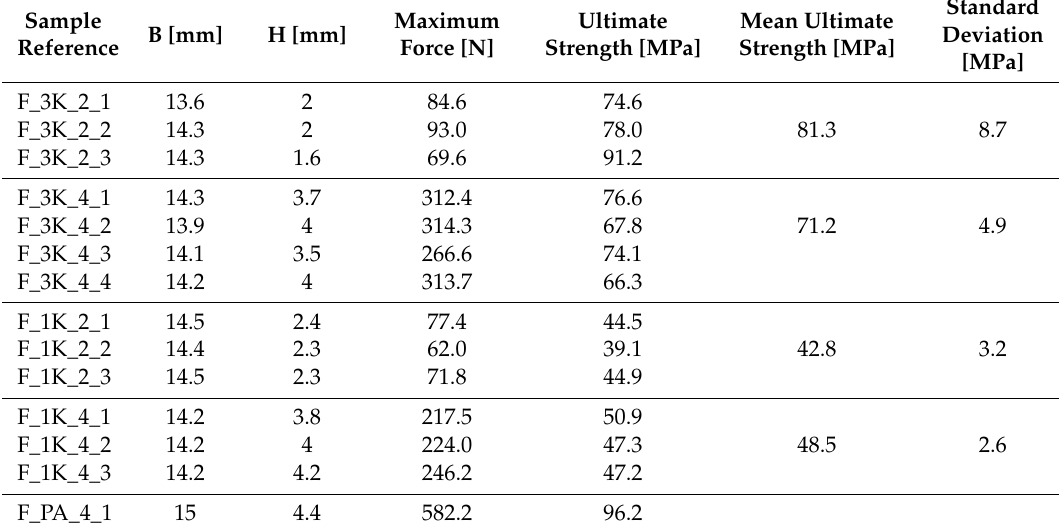
Table 6. Three-point bending test data (c) the authors, CC BY-NC-ND 4.0 [17].